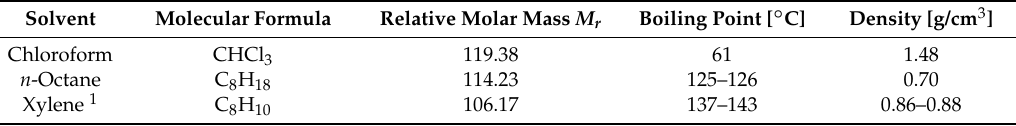
Table 2. Properties (manufacturer specifications) of the organic solvents used for the VOC sensing experiments.